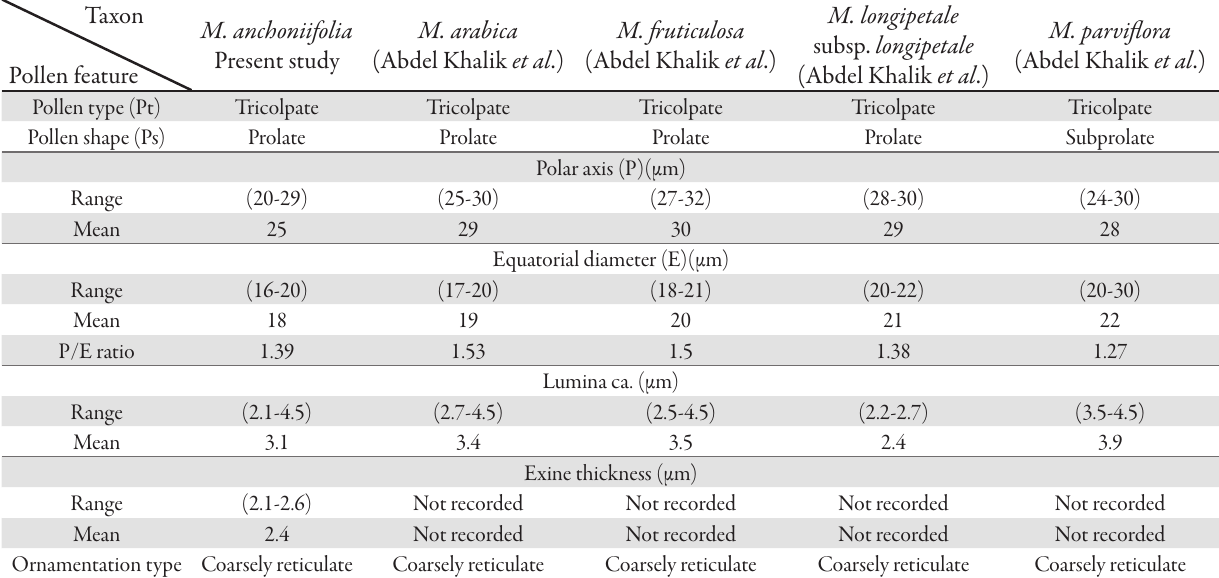
Tab. 2. The comparison of the pollen morphological characters obtained from Matthiola anchoniifolia with other species (P: polar axis; E: equatorial diameter; P/E: the ratio between the polar axis and equatorial diameter; Pt: Pollen type; Ps: pollen shape; Lumina ca.: lumina size)